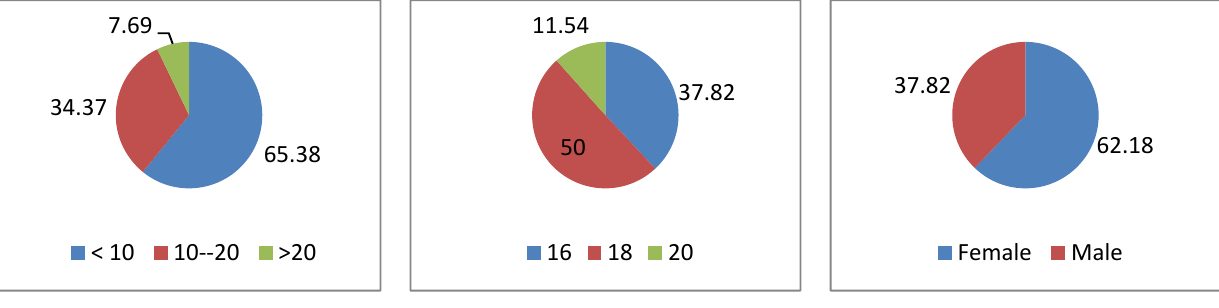
Fig. 2. Personal characteristics of participants